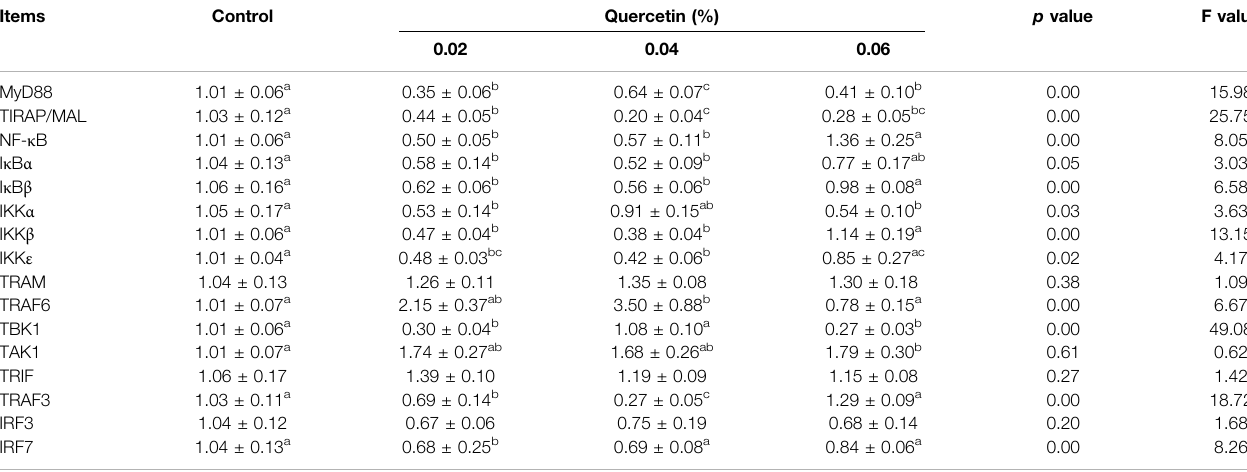
TABLE 10 | Effect of quercetin on the mRNA expression of genes related to the Toll-like receptor signaling pathway in the ileum of AA broilers. Items